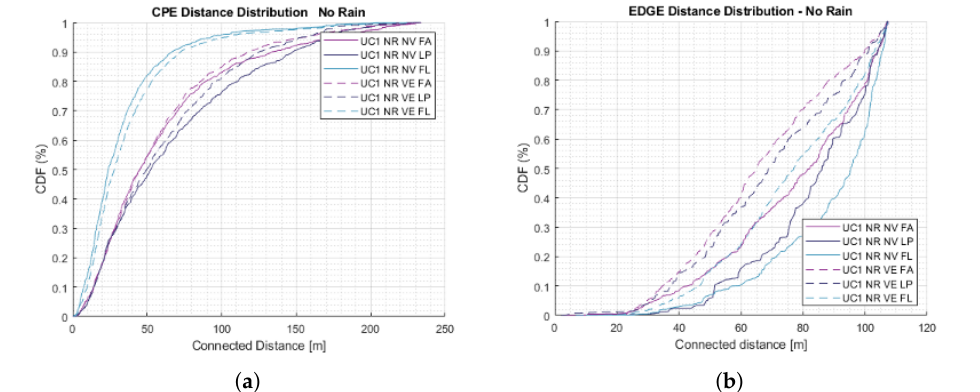
Figure 9. Distance distribution. ( a ) Between CPE and ENs. ( b ) Between